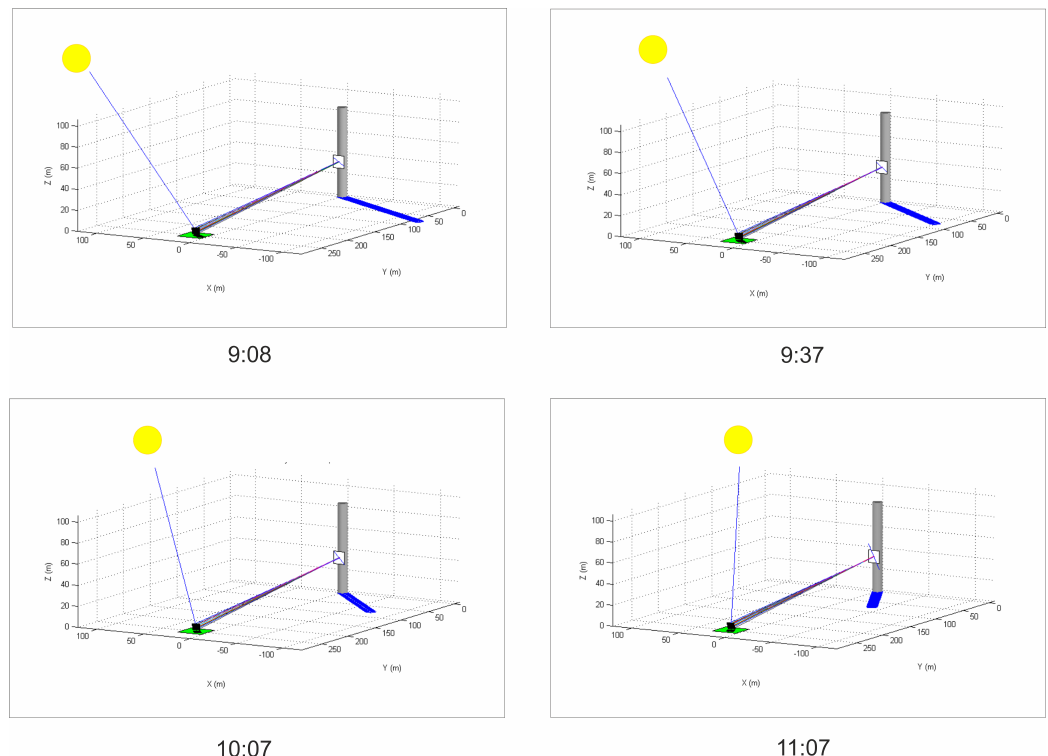
Figure 10. Scheme of the DNI forecasting simulation on the target (10 March 2017 at 9:07